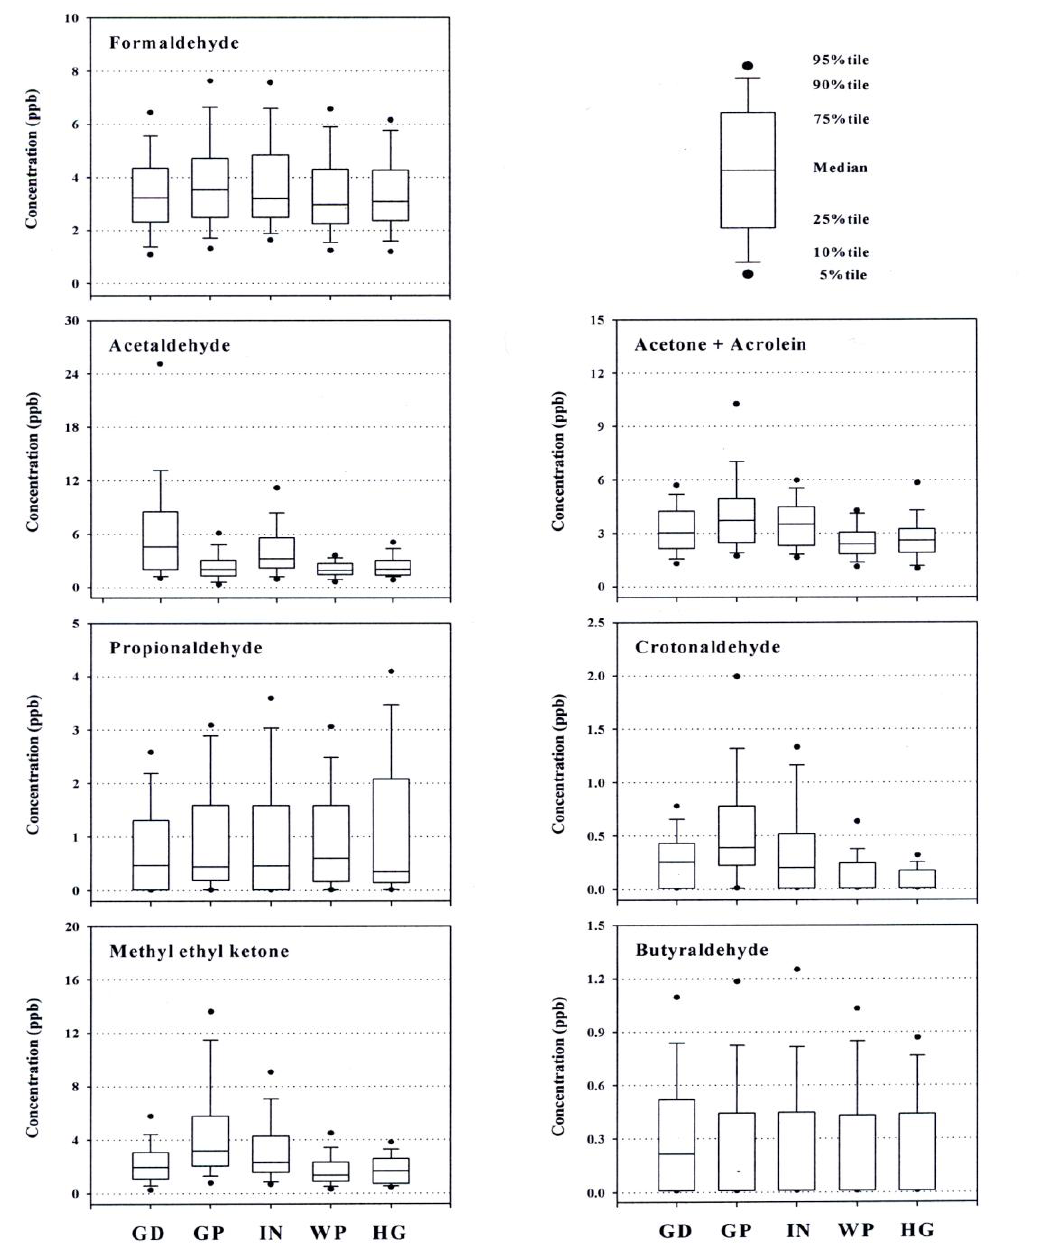
Figure 2. Comparison of concentration distributions for each sampling site; GD: the 1st industrial site; GP: the 2nd industrial site; IN: the 3rd industrial site; WP: commercial site; HG: residential